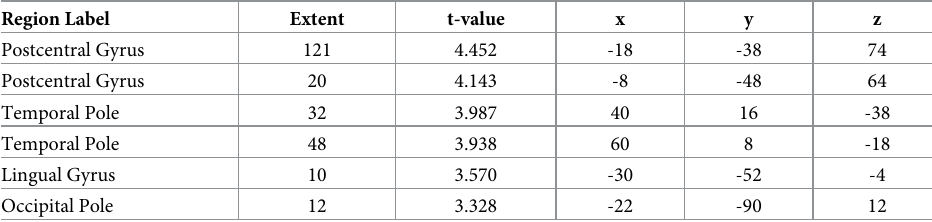
Table 3. Deactivated regions that exhibited a significant positive correlation with performance (p < .05 FDR). Region